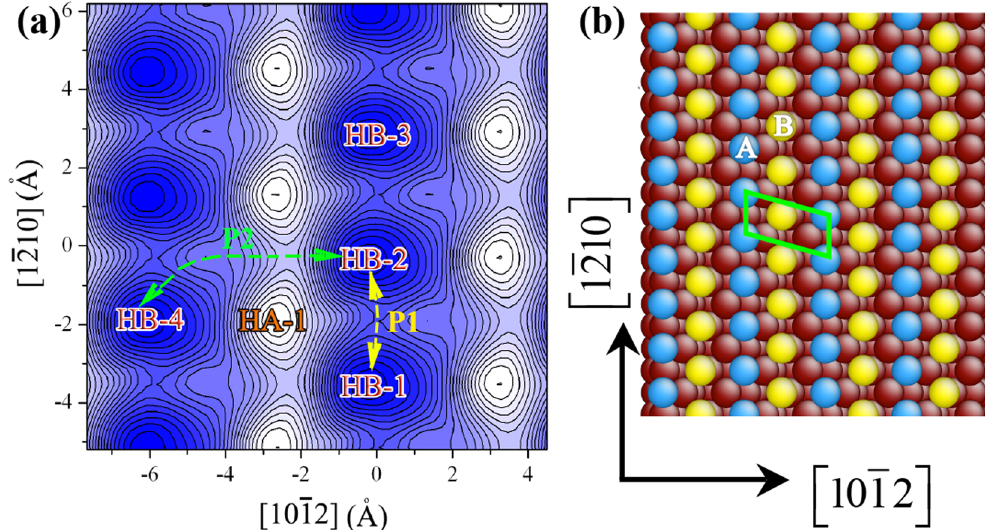
Figure 3. ( a ) Atomic structure of surface ¯ {1011} . ( b ) The potential landscape in association with the diffusion of an adatom on ( ¯ 1011 ) surface. HA and HB indicate the lattice